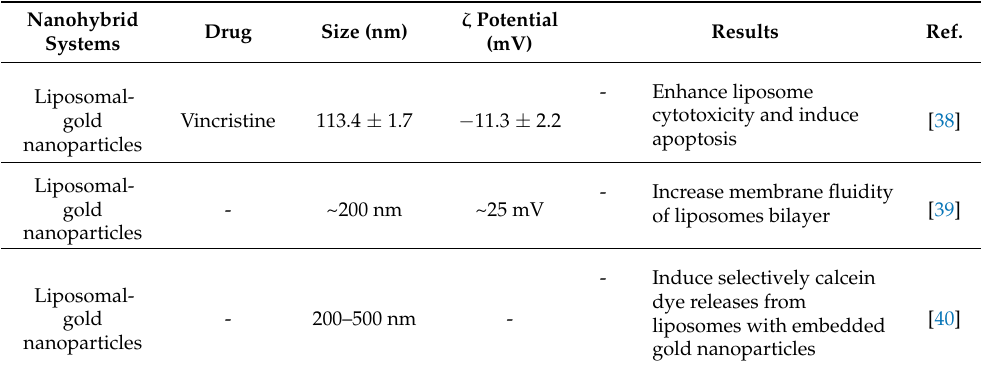
Table 1. Ultraviolet-visible light stimulus effect on the nanohybrid liposomal-metallic nanoparti- cle